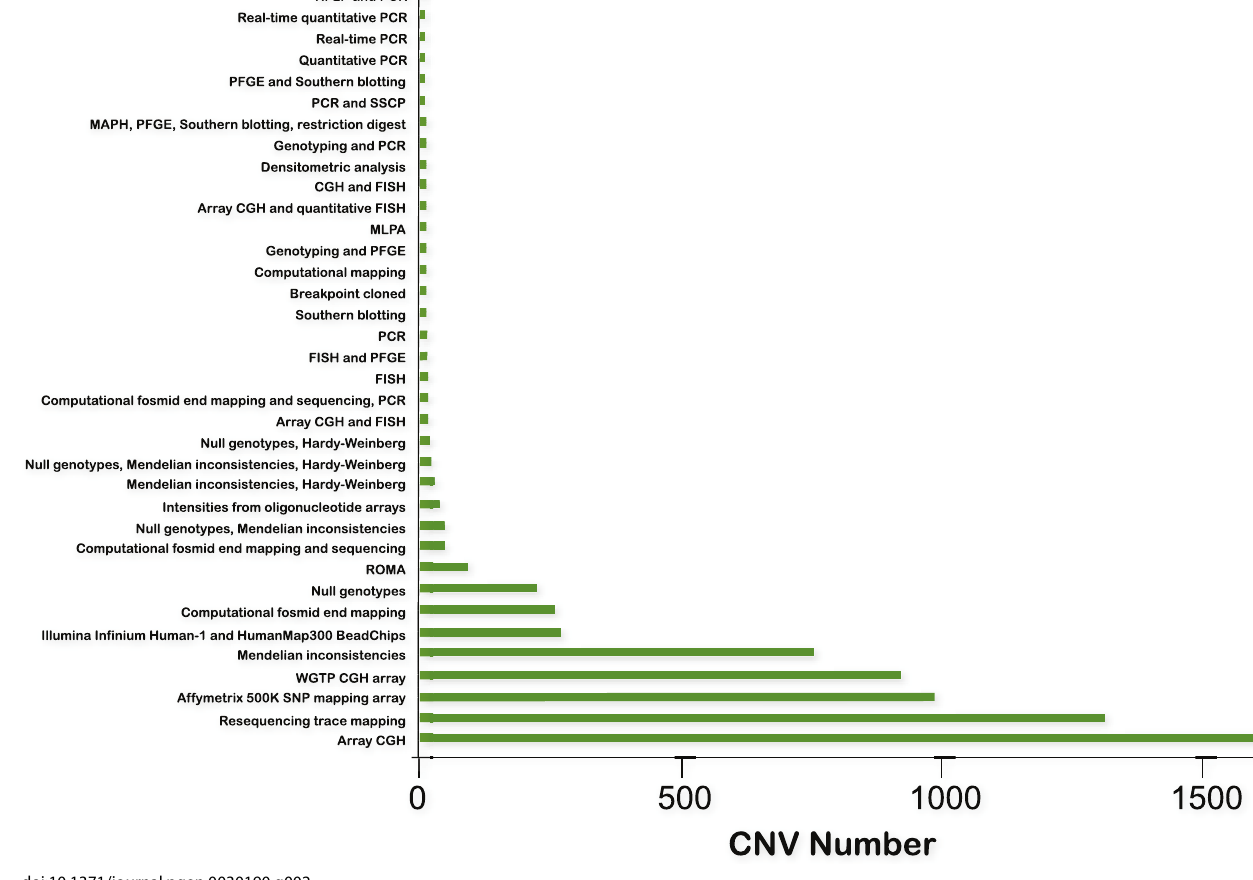
Figure 2. Approaches Used for the Identification of CNVs and Other Types of Structural Changes in the Human Genome Myriad methods and technologies have been employed to identify structural variants in the human genome. They are based on completely different experimental procedures and provide very different levels of resolution. The majority of findings ( . 80%) are attributable to a restricted number of high- throughput experiments with a limited